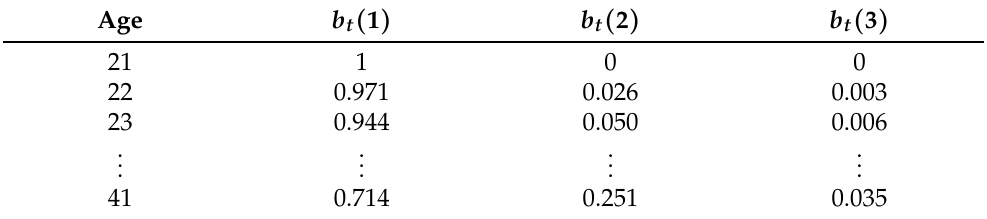
Table 1. Impact of starting late to screen on the health state of a 41 year old patient who has been healthy at age